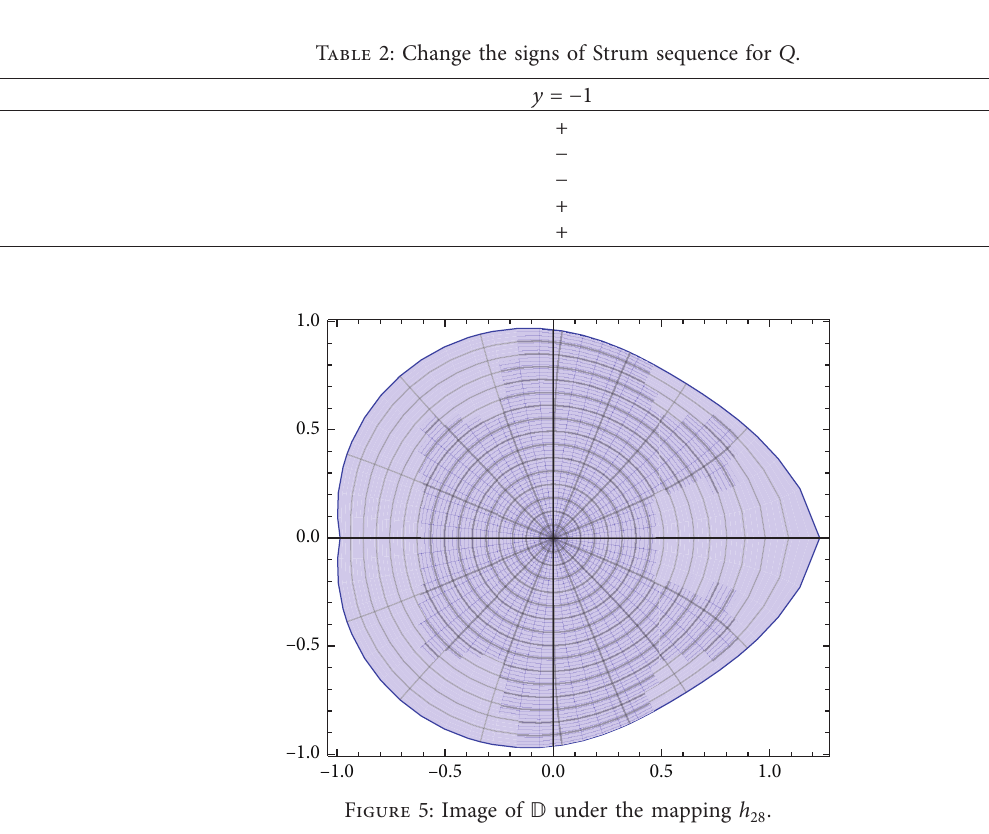
Table 1: Change the signs of Strum sequence for P